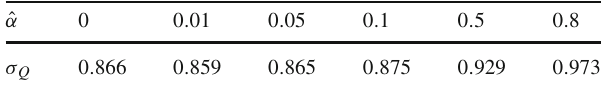
Table 1 The characteristic quantity of incoherence σ Q for γ = 1 / 12 and different ˆ